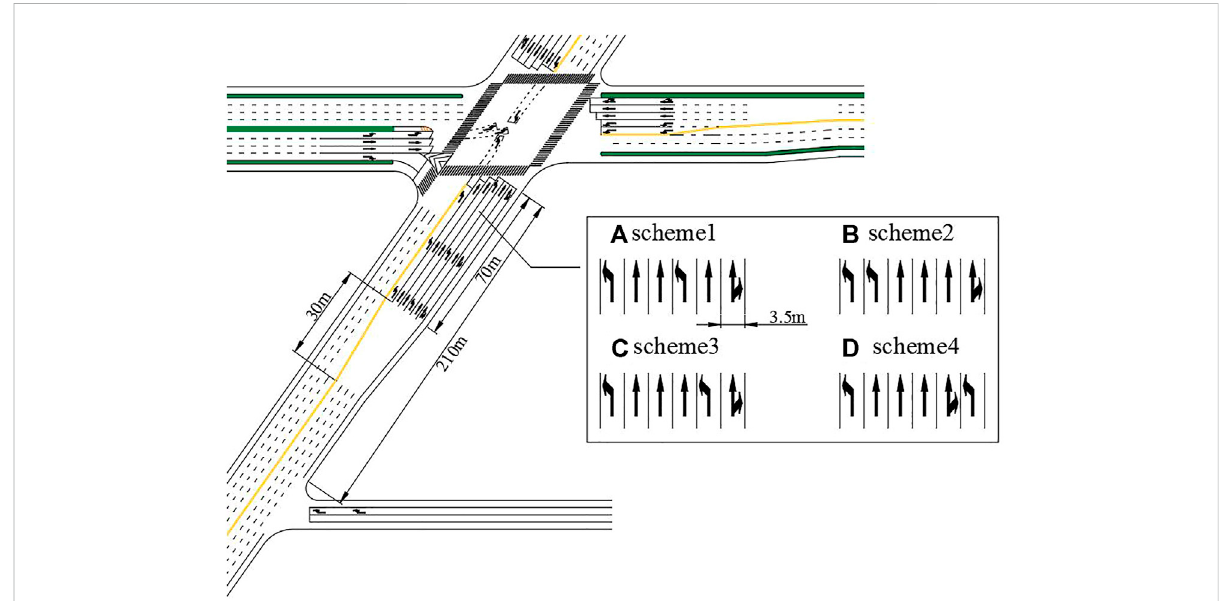
FIGURE 5 Typical outside left-turn lane location setting scheme. (A) Scheme1: The outside left-turn lane is located in the middle lane, (B) Scheme2: The outer left-turn lane is located in the inner lane, (C) Scheme3: The outer left-turn lane is located in the sub-outermost lane, (D) Scheme4: The outer left-turn lane is located in the outermost lane.